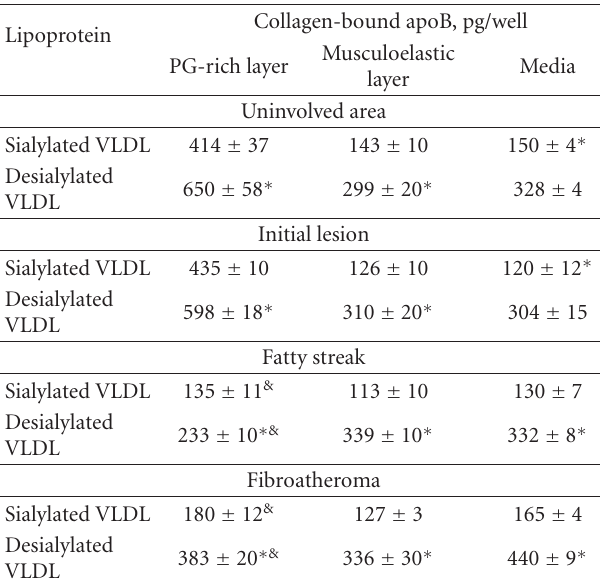
Table 2: Binding of sialylated and desialylated IDL to collagen isolated from two layers of the intima and the media of uninvolved and atherosclerotic areas of human